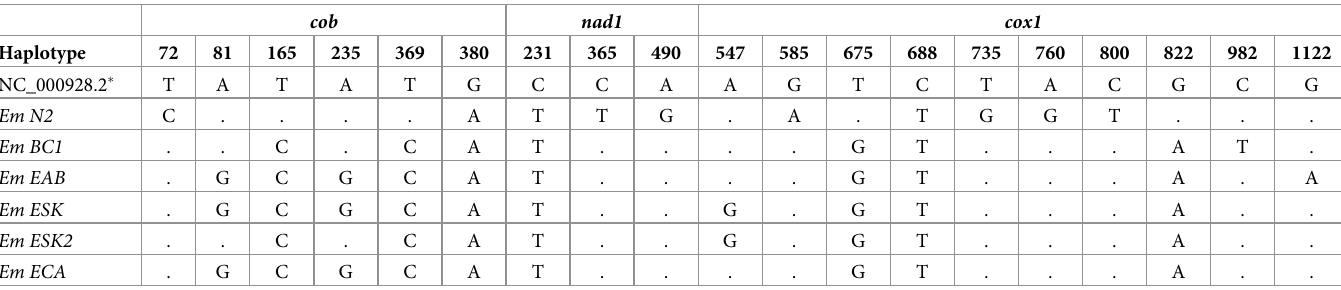
Table 1. Single nucleotide substitutions of cob , nad1 and cox1 genes found in six haplotypes of Echinococcus multilocularis . cob nad1 cox1 Haplotype